Question: What visual encoding does this figure use to show its data?
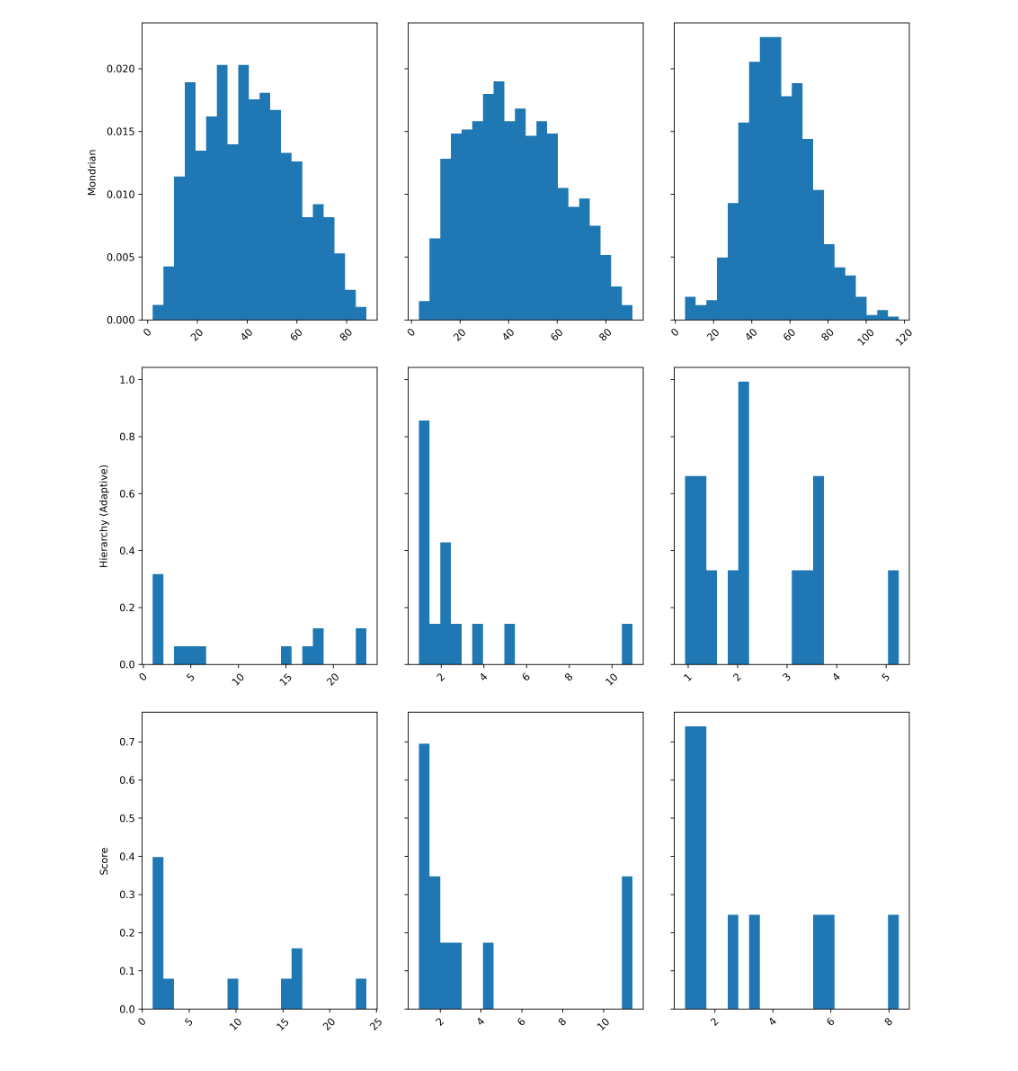
Answer: box